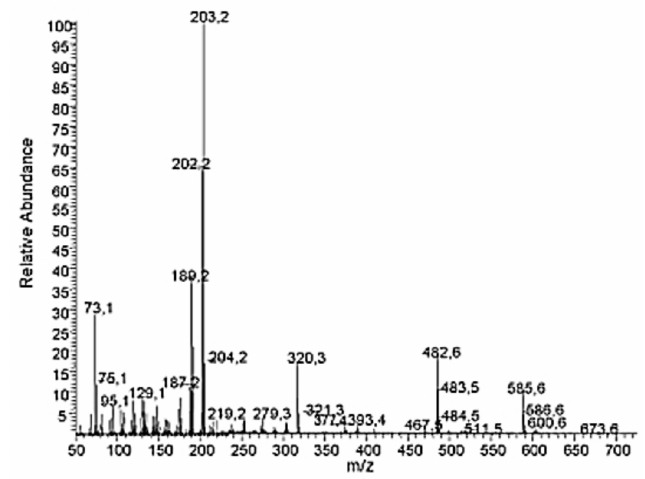
Figure 4. Mass spectrum of oleanolic acid, showing five major m/z fragments: 203.2; 202.2; 189.2; 73.1;